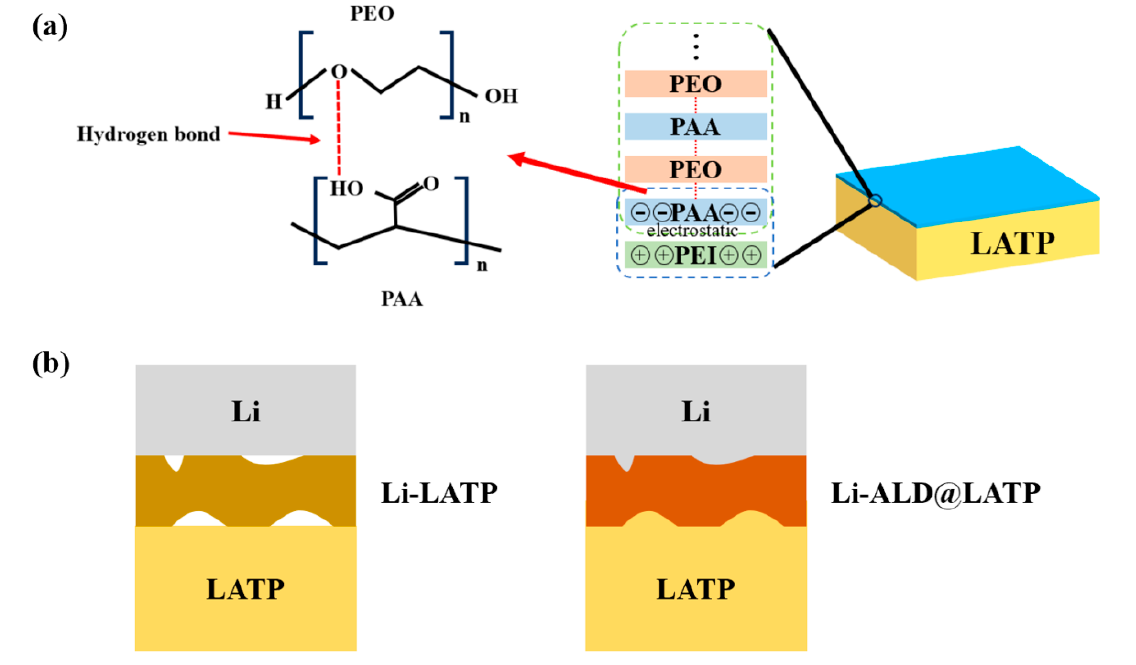
Figure 6. ( a ) Schematic of ( PAA/PEO ) layer on the LATP. ( b ) Schematic of LATP/Li interface of LATP coated with Al 2 O 3 by ALD.